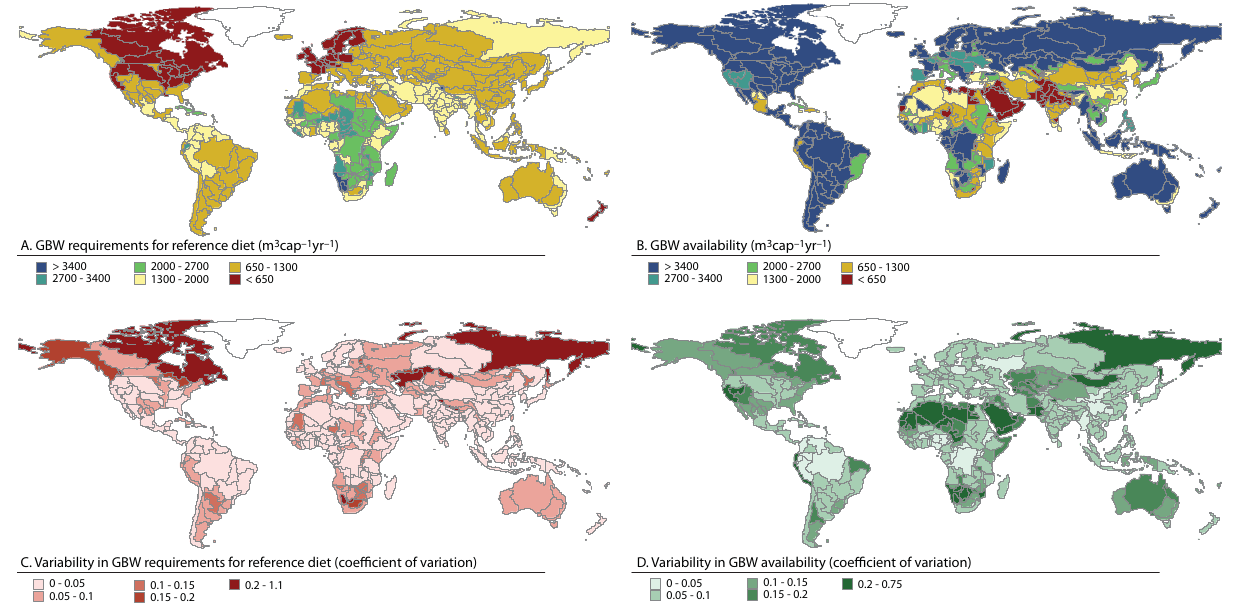
Fig. 1. Green-blue water (GBW) requirements for reference diet and GBW availability. (A) Average GBW requirements over 30yr climatic period; (B) average GBW availability over 30yr climatic period; (C) variability in GBW requirements measured with coefficient of variation (CV); and (D) variability in GBW availability measured with